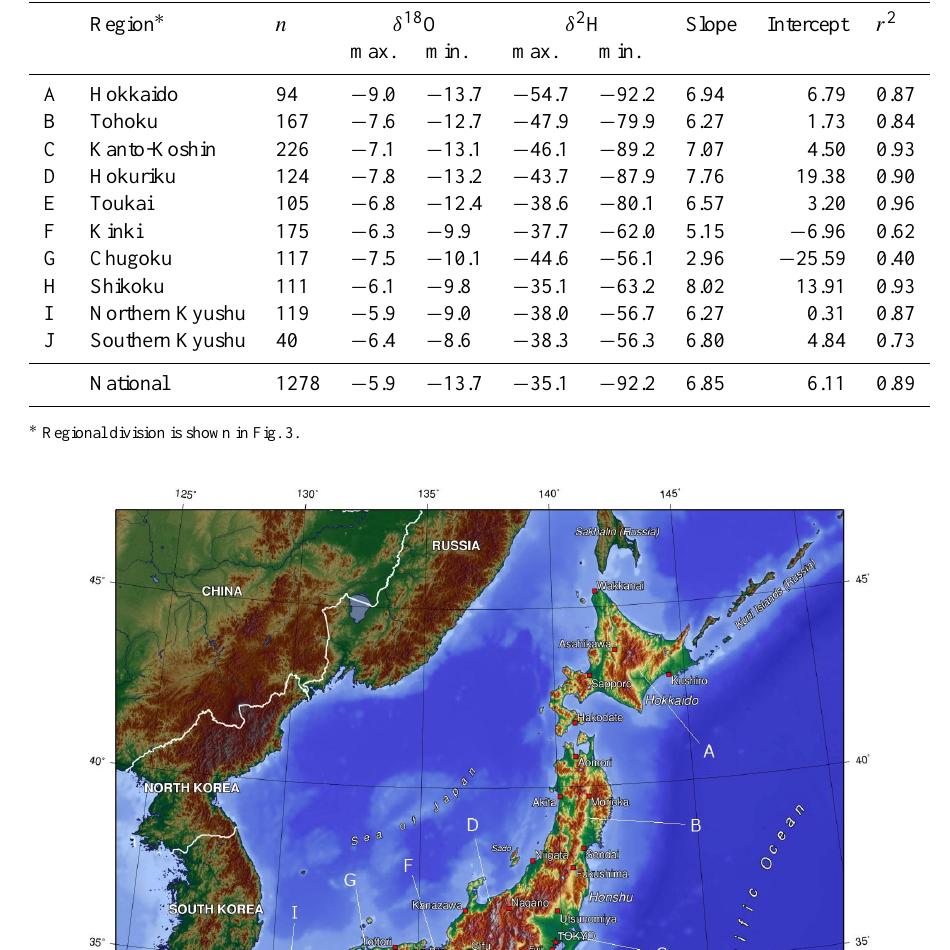
gions (not shown). The slopes of these lines were relatively smaller at the prefectures of the Sea of Japan side – e.g., imply that there are plural potential regression lines within the data ellipse at each region as results of the contribution from different moisture sources. To find the final solution